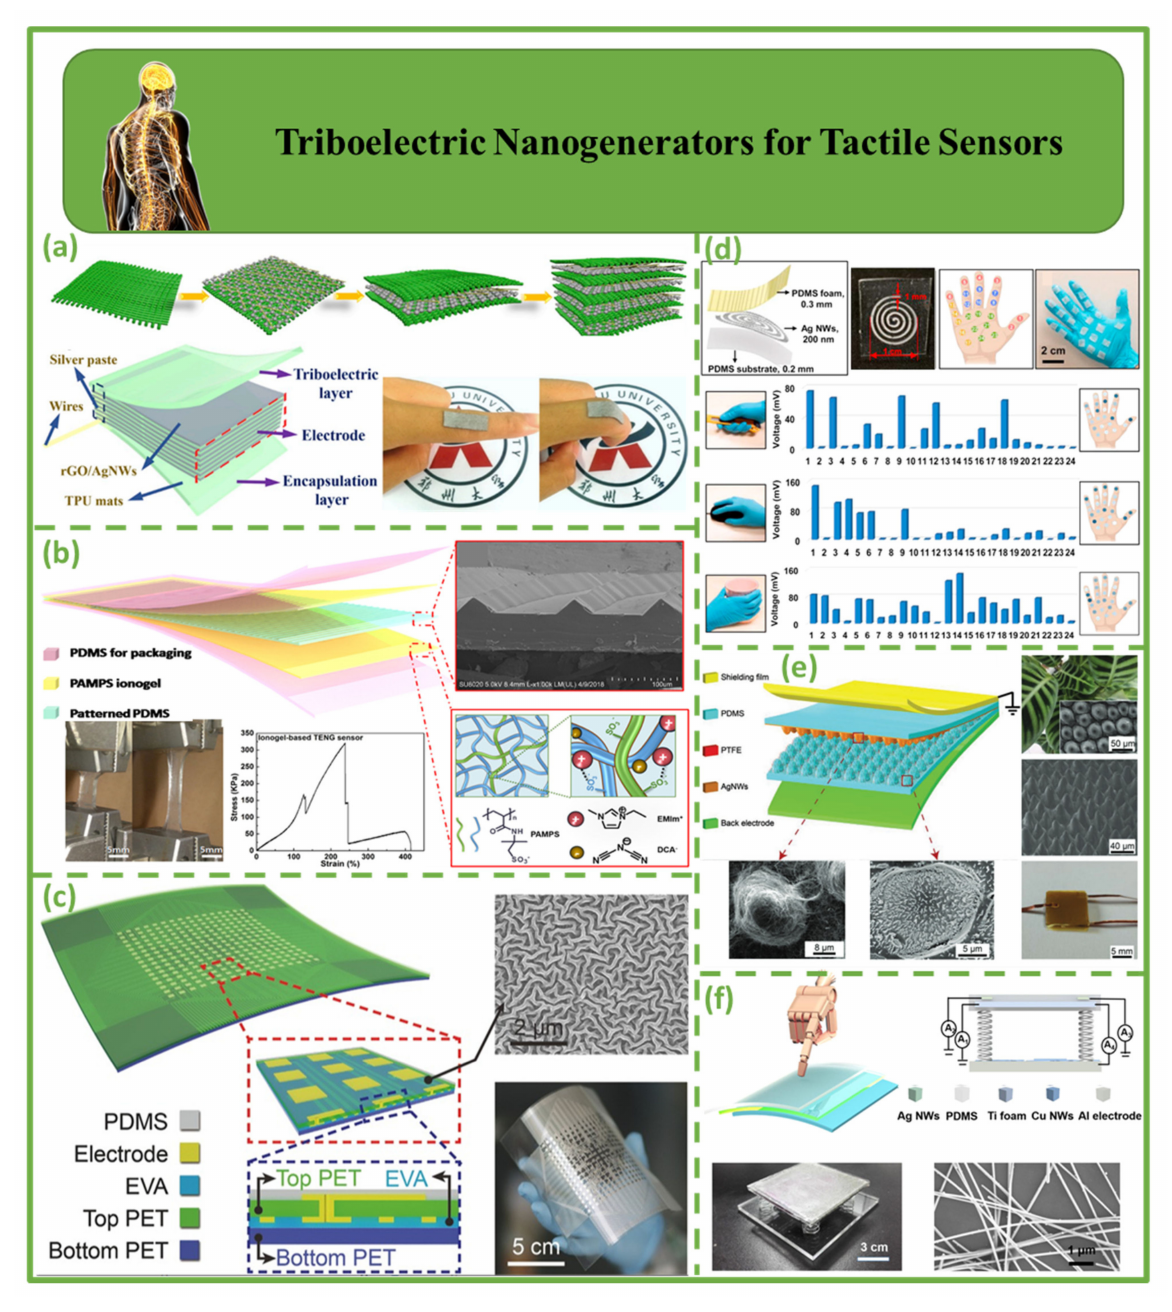
Figure 9. Demonstration of triboelectric nanogenerators for tactile sensors. ( a ) Structural diagram of STENG-based e-skin [115]. ( b ) Transparent and stretchy TENG-based tactile sensor structure [116]. ( c ) TESM structure for real-time tactile mapping [78]. ( d ) Foam-based TENGs as tactile glove sen- sors [119]. ( e ) Diagrammatic representation of the mechanism of TENG e-skin sensors [120]. ( f ) Prin- ciple of smart tactile sensors